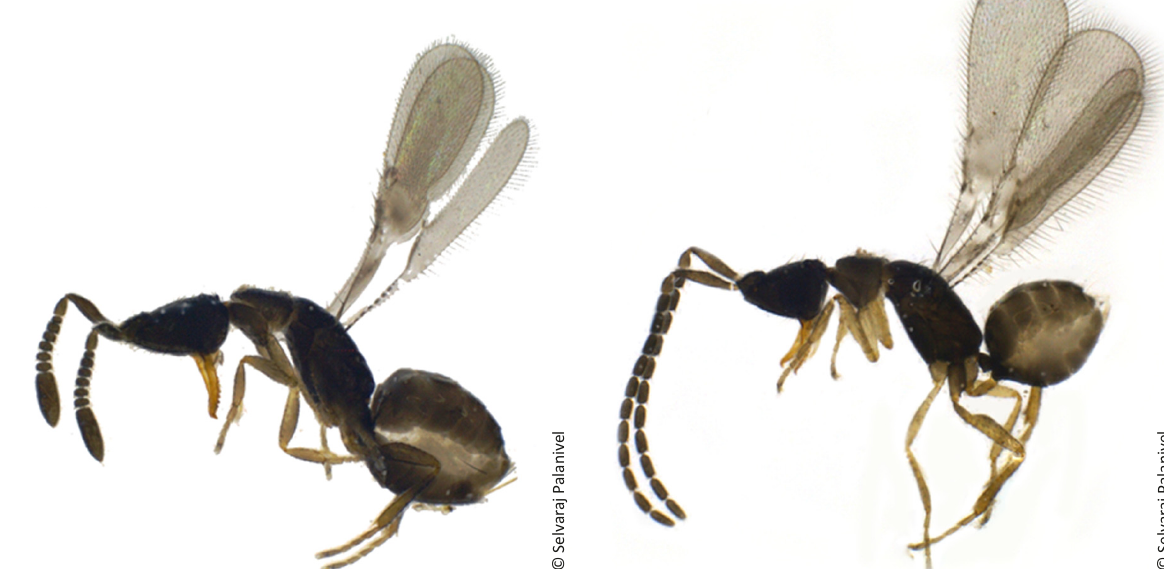
Image 2. Eubroncus scutatus sp. nov. - habitus image of